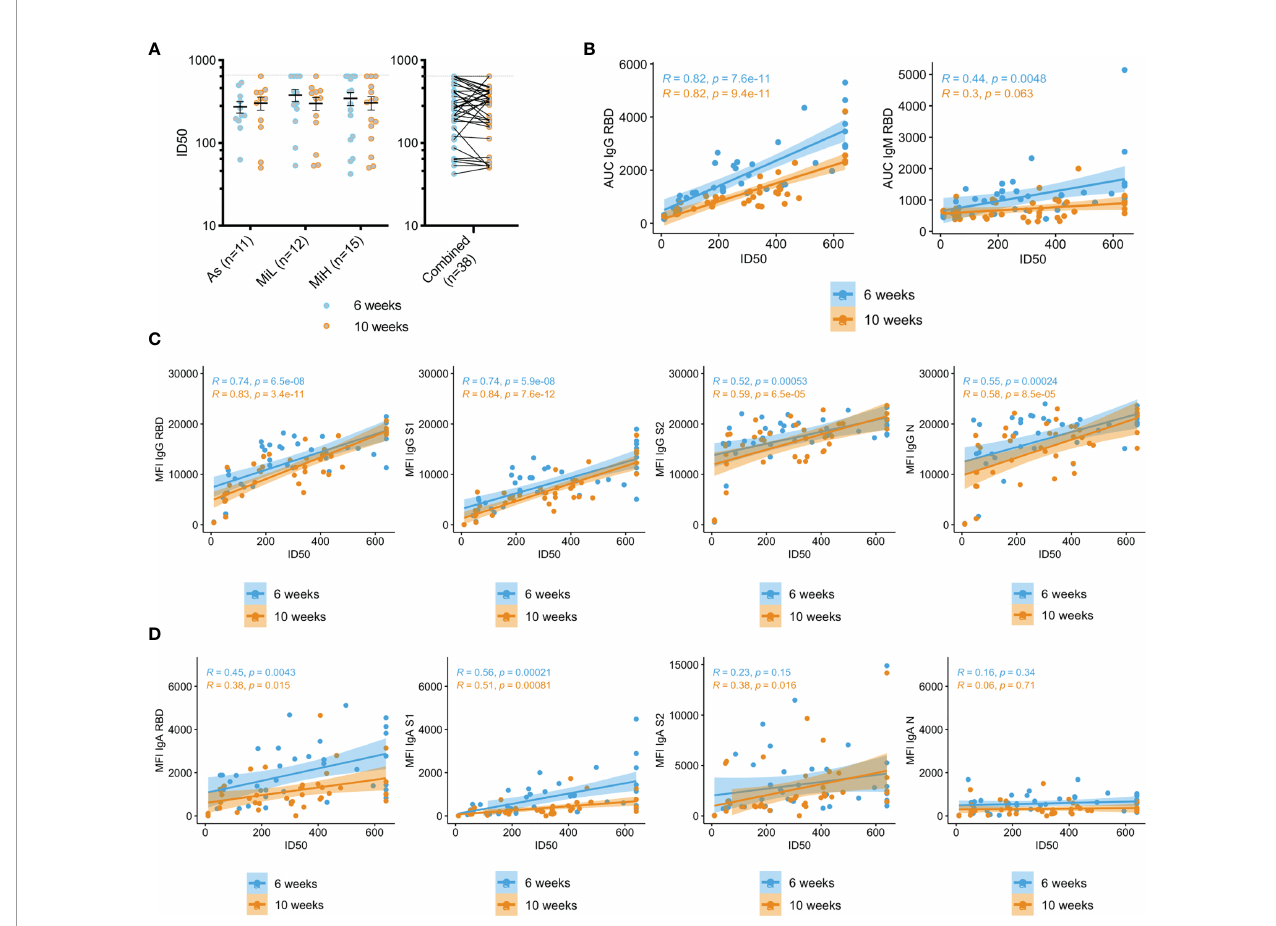
FIGURE 2 | Neutralization activity in sera in As, MiL, MiH or the three groups combined (A) and correlation of neutralization ID 50 values with SARS-CoV-2 speci fi c antibodies (B – D) . B) Correlation analysis of RBD IgG and IgM levels calculated by ELISA (AUC values) and neutralization activity (ID 50 ). (C, D) Correlation analysis of IgG (C) and IgA (D) antibodies directed towards SARS-CoV-2 RBD, S1, S2 and N using a Luminex xMAP-based multiplex assays (MFI) and neutralization activity (ID 50 ). Mean and SEM are indicated. Dash line in A) shows the upper limit of detection. Two-way ANOVA test followed by multiple comparisons with Benjamini- Hochberg method (desired FDR 0.05). ID 50 , half maximal inhibitory dilution. AUC, Area under the curve; MFI, Mean Fluorescence Intensity; R , Pearson correlation coef fi cient; P ,